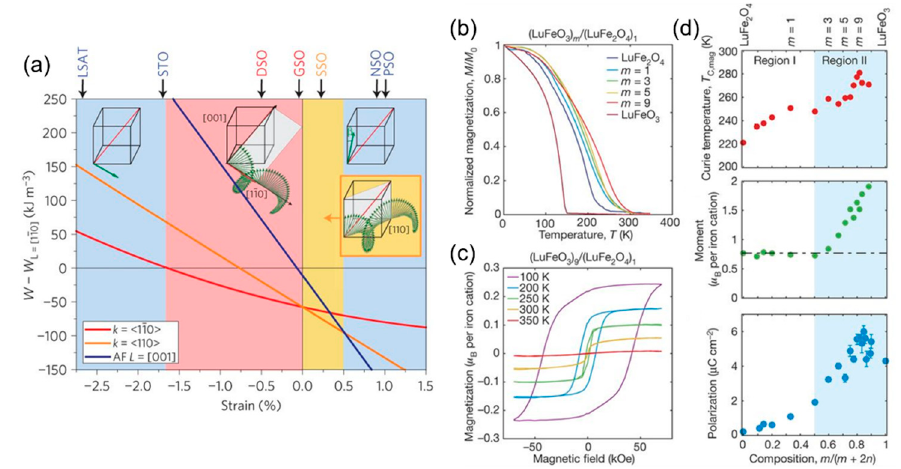
Figure 2. ( a ) The energy of three magnetic states in BFO thin films (cycloid with propagation direction along < 11(cid:3364)0 >, along <110>, and collinear antiferromagnetic order close to [001]) relative to the energy of collinear antiferromagnetic order with antiferromagnetic vector along in-plane [ 11(cid:3364)0 ]. Tuning the in-plane strain results in stability of different states. Reprinted with permission from [60], copyright Springer Nature, 2013. ( b , c ) Magnetization vs. temperature for a series of (LuFeO 3 ) m /(LuFe 2 O 4 ) 1 superlattices and the magnetization loops as a function of the magnetic field for the (LuFeO 3 ) 9 /(LuFe 2 O 4 ) 1 superlattice. ( d ) The ferromagnetic Curie temperature, the total moment per iron cation in LuFe 2 O 4 at 50 K assuming the moment of LuFeO 3 remains constant and average polarization from high-angle annular dark-field imaging in scanning transmission electron microscopy for superlattice layering plotted as a function of composition. Regions I and II show data for the (LuFeO 3 ) 1 /(LuFe 2 O 4 ) n and (LuFeO 3 ) m /(LuFe 2 O 4 ) 1 series, respectively. Reprinted with permission from [63], copyright Springer Nature, 2016.